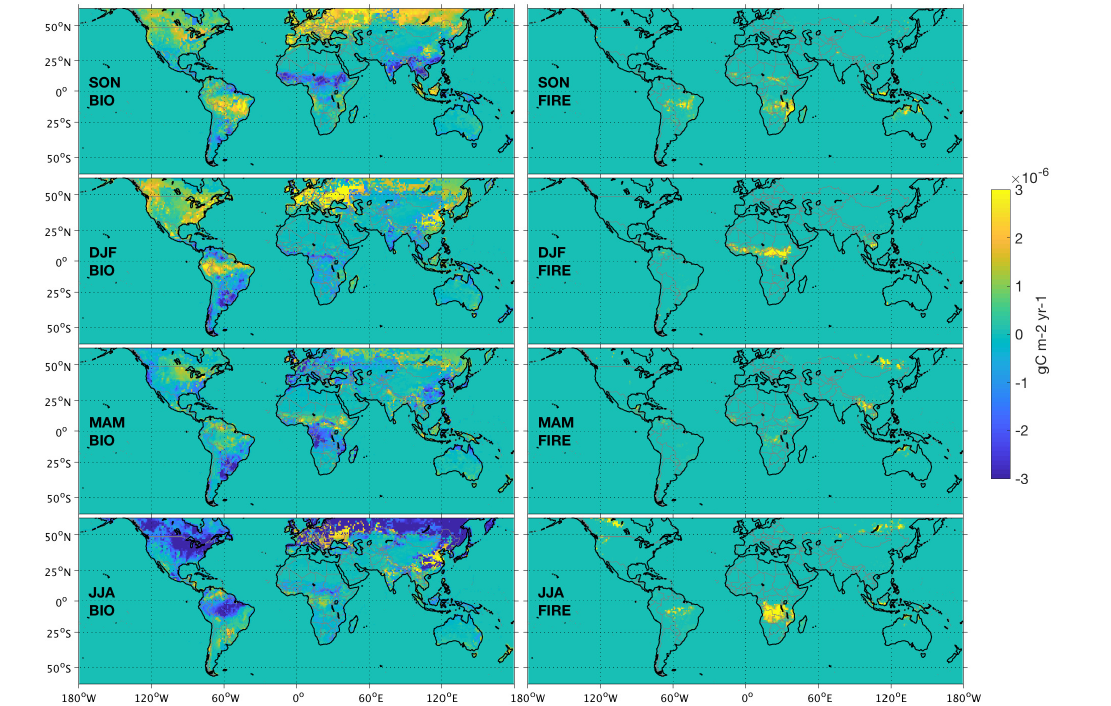
Figure 6. Seasonal biospheric (BIO) and biomass burning (FIRE) fluxes from NOAA’s CarbonTracker CT2017 from September 2014 to August